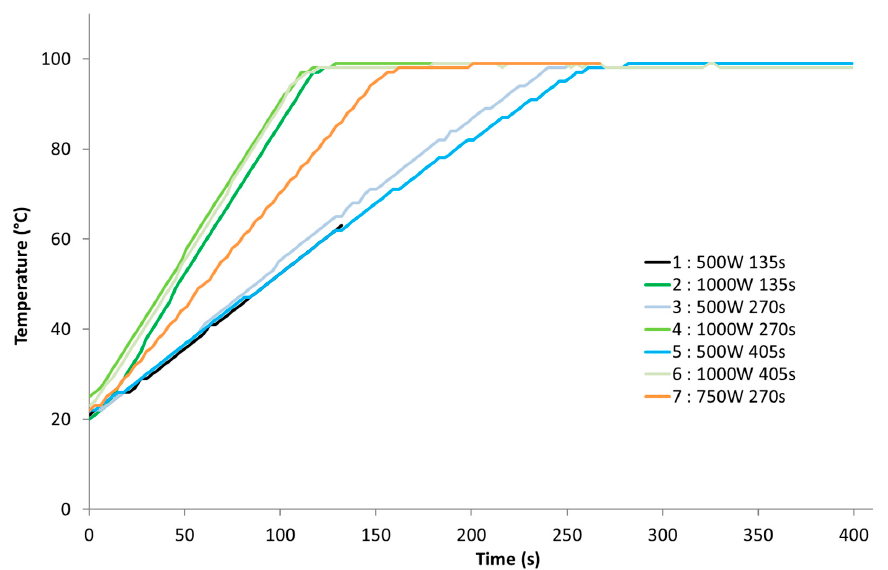
Figure 6. Temperature rise during response surface methodology (RSM) experiments.